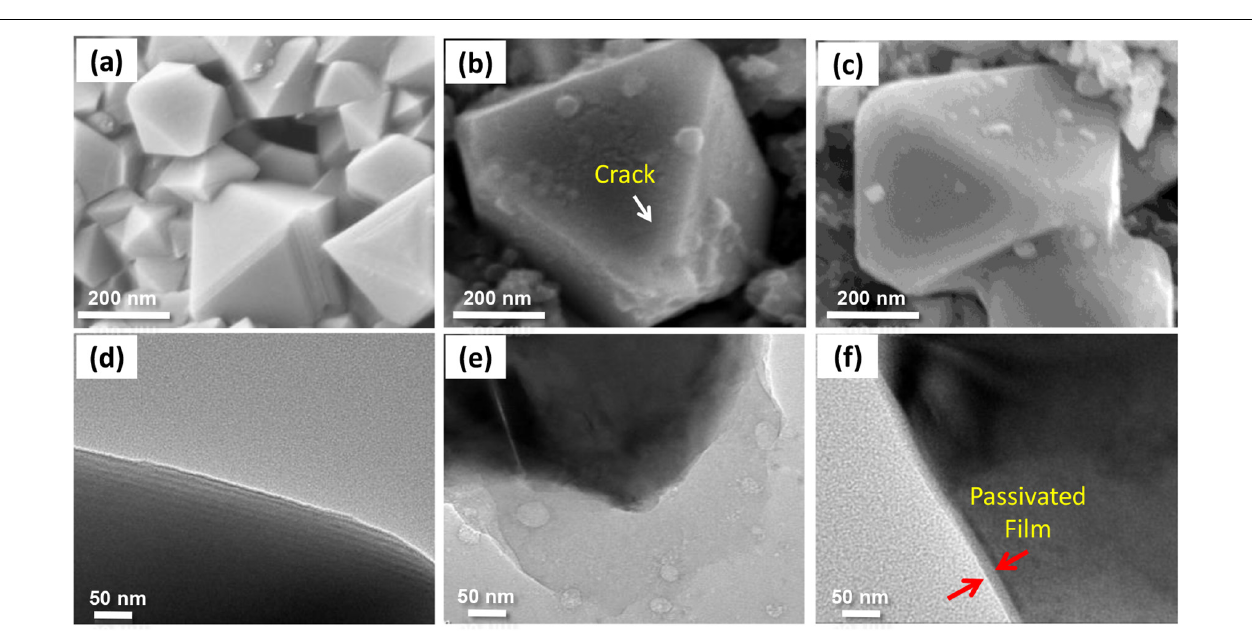
FIGURE 7 | SEM and TEM images for pristine LiMn 2 O 4 cathode (a,d) and the cathode that have been cycled without (b,e) , with 5 wt.% PS (c,f)